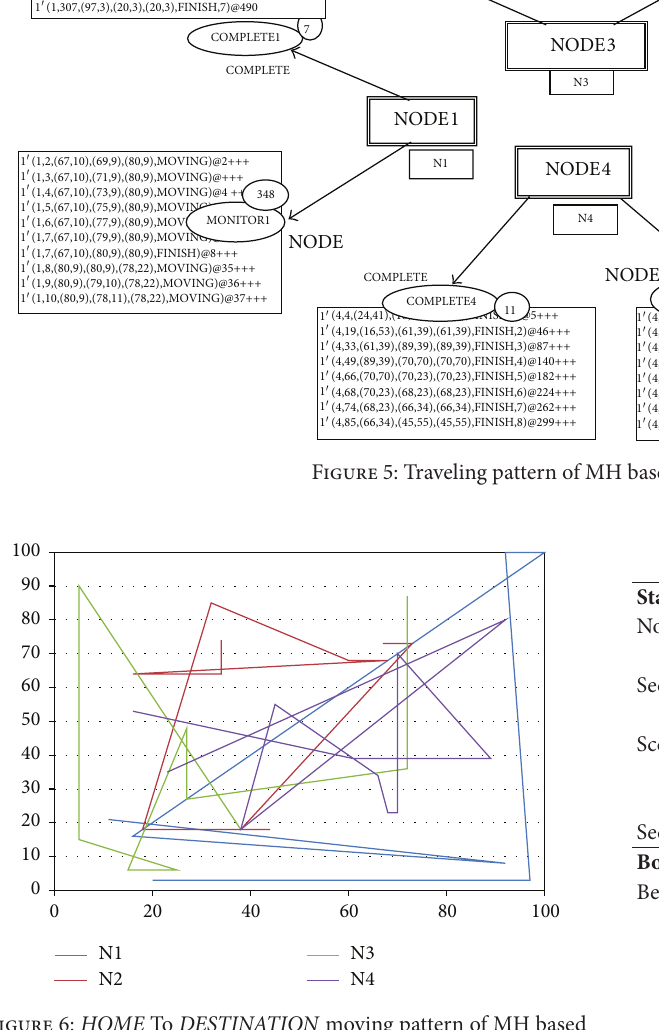
Figure 6: HOME To DESTINATION moving pattern of MH based on Table 3.